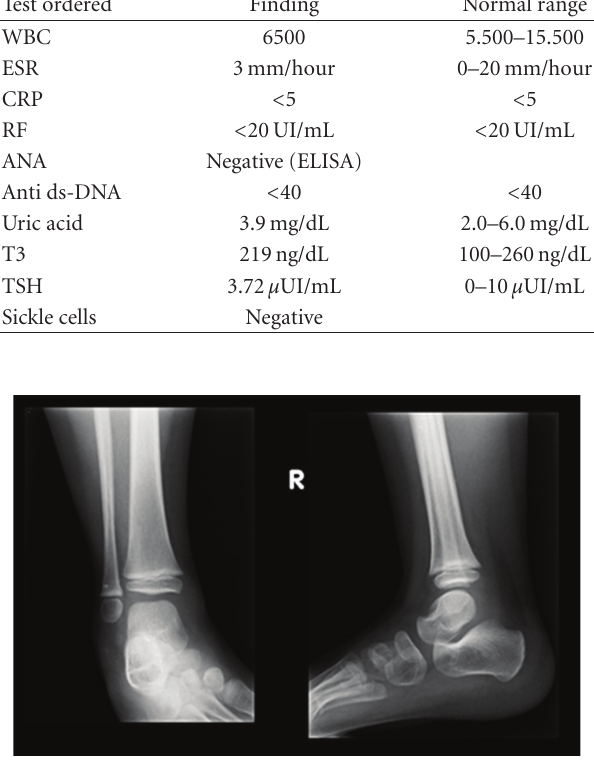
Figure 1: AP and lateral X-ray of the 4-year-old patient with normal findings.